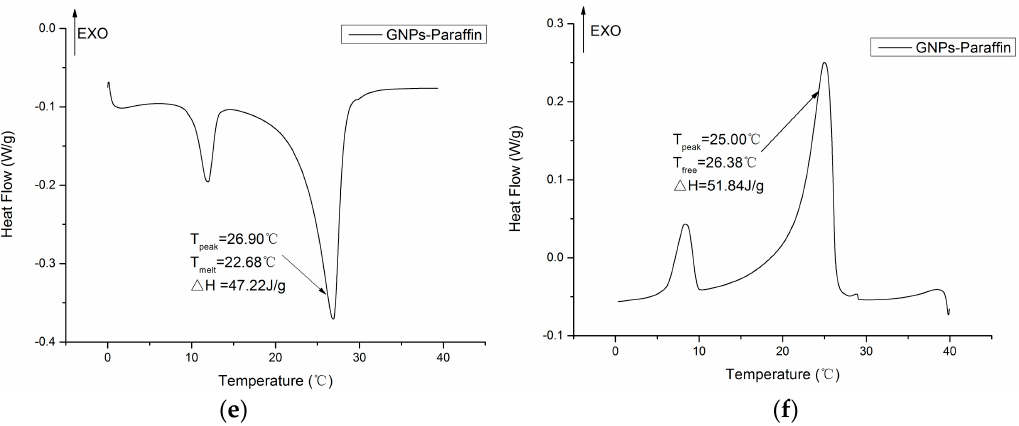
Figure 6. DSC thermograms—paraffin and CPCMs. ( a ) endothermic curve of paraffin; ( b ) exothermal curve of paraffin; ( c ) endothermic curve of EG-paraffin; ( d ) exothermal curve of EG-paraffin; ( e ) endothermic curve of GNPs-paraffin; ( f ) exothermal curve of GNPs-paraffin.